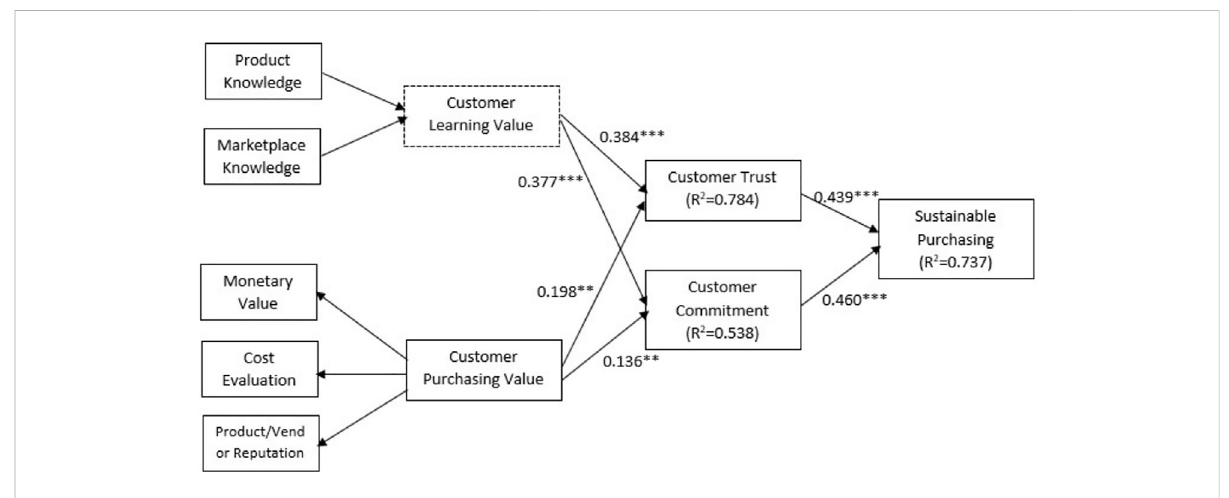
FIGURE 2 Results of the research